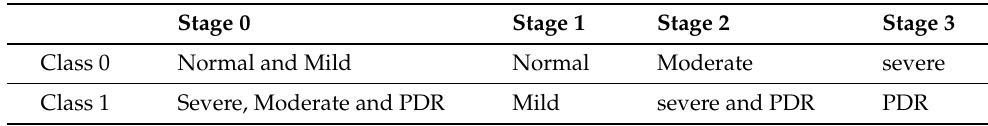
Table 4. Class divisions (0–1) for each stage of Cascaded